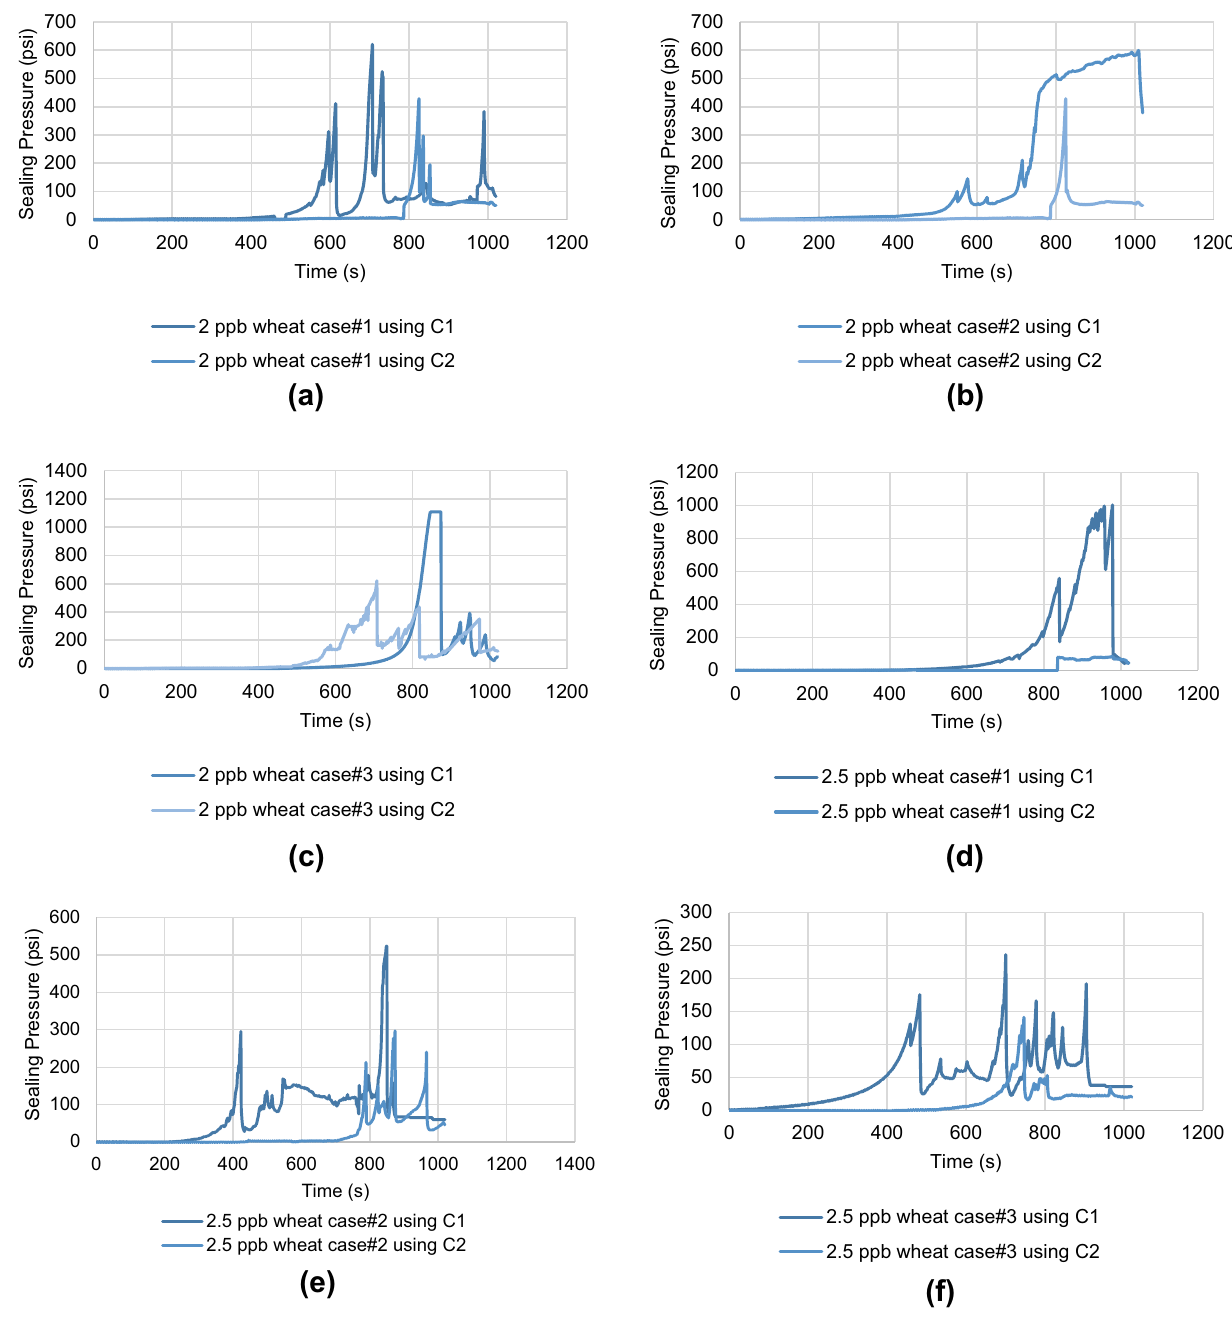
Fig. 20 HPA Pressure versus Time plot for 2 & 2.5 ppb Wheat Straw showing maximum sealing pressure at different fracture widths, a